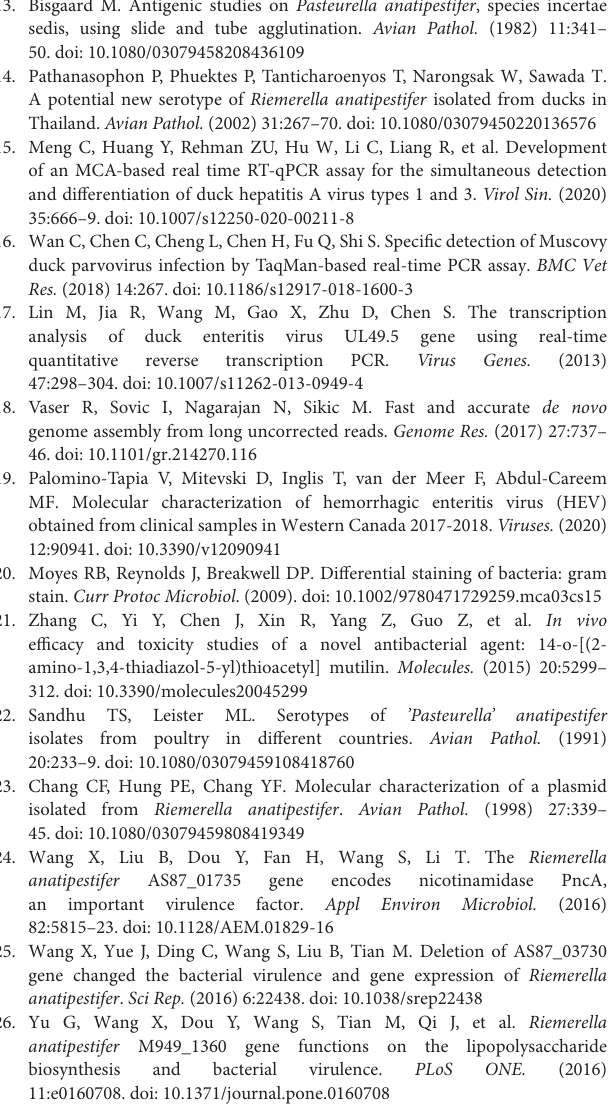
Supplementary Figure 1 | The results of identification of isolated strains. (A) Gram strain results of isolated strains. (B) PCR identification of isolated strains. M means DNA marker; NC means negative control; PC means positive control; RA means identified R.anatipestifer . Supplementary Table 1 | Primers used in this